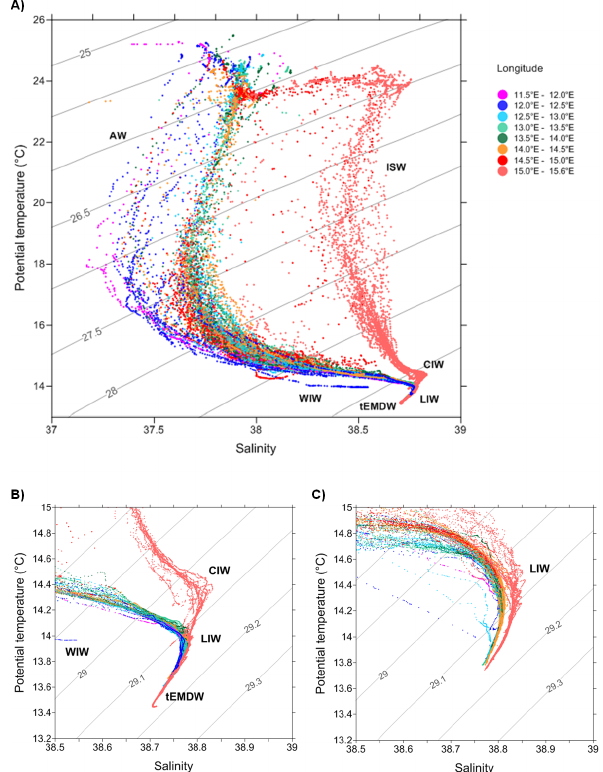
Figure 2. (a) θ - S diagram for the survey Juvenile99 (Strait of Sicily and west Ionian Sea). The colors refer to longitude of the stations. θ - S diagrams in the salinity range 38.5–39 for the survey Juvenile99 (b) and Ansic04 (c)